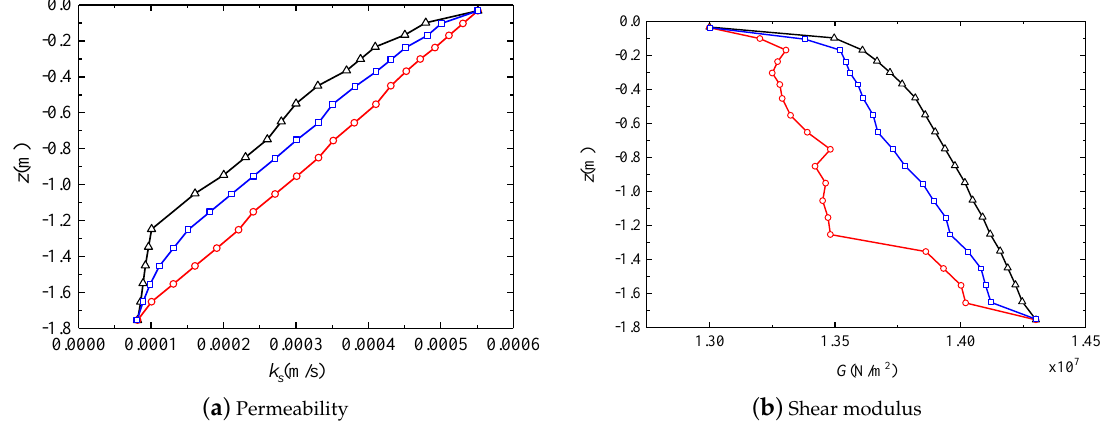
Figure 8. Soil parameters (soil permeability, shear modulus) versus seabed depth measured in a non-homogeneous sandy seabed for different cases. Black triangle: Case 1; Red circle: Case 2; Blue square: Case 3.